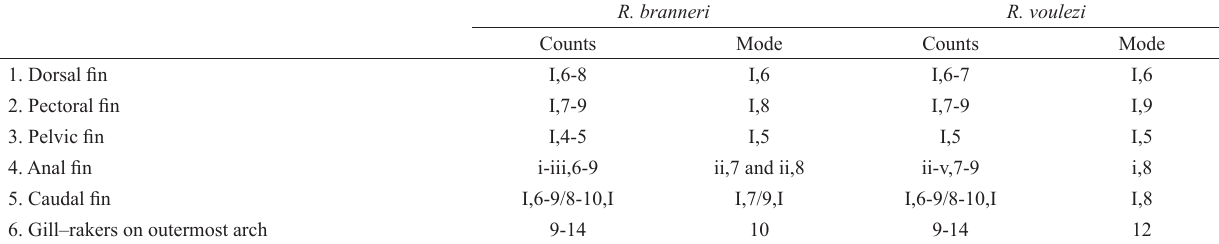
Table 2. Meristic characters of Rhamdia branneri and R. voulezi